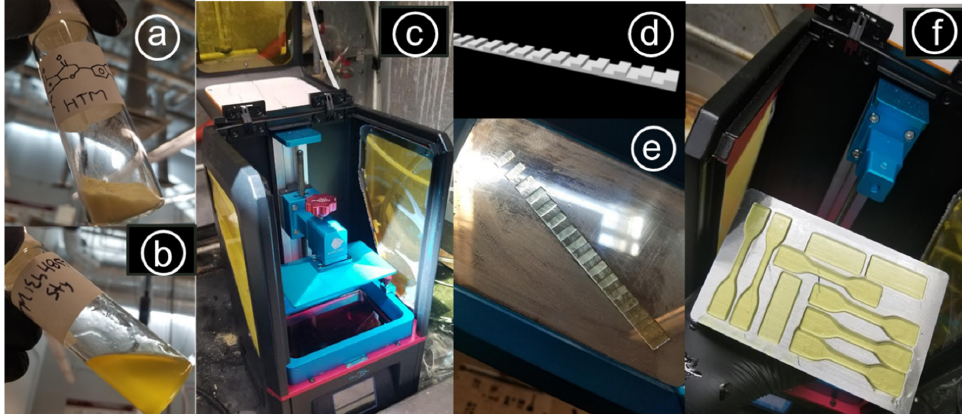
Figure 9. Photographs of formulations and prints detailing work flow for HTM SLA resin formulations. ( a ) Pure HTM (yellow powder). ( b ) HTM:Eb4859:Sty liquid resin formulation. ( c ) AnyCubic Photon 3D printer used in this investigation. ( d ) SLA print file for print used to make working curve. ( e ) 3D print used to measure cure depth in order to plot working curve. ( f ) HTM:Eb4859:UDM 3D printed DMA and tensile test coupons.